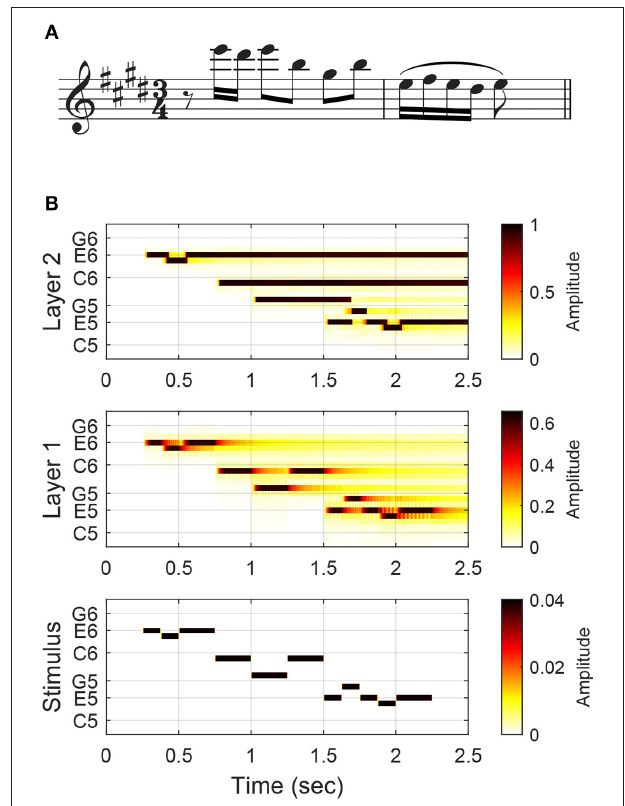
FIGURE 2 | The model’s response to the opening of J. S. Bach’s Violin Partita No. 3, BWV 1006, Prelude: (A) the musical score and (B) the amplitudes of Layer 1 and Layer 2 oscillators and stimulus tones. The stimulus (an audio signal) is depicted in a piano-roll representation. High-amplitude oscillations in Layer 2 (depicted with dark colors) are considered active pitch traces in auditory